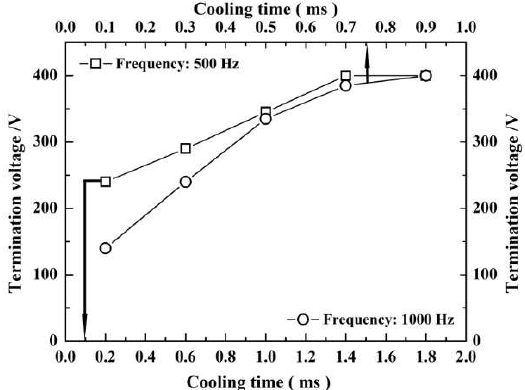
Figure 9. The tendency of large-arc discharge at frequencies of 500 Hz and 1000 Hz, with a duty cycle from 10% to 90%.